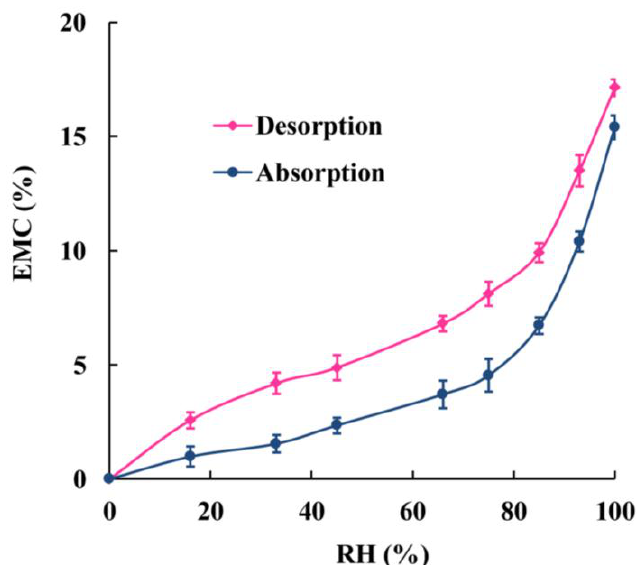
Figure 1. Typical sorption and desorption isotherms for type 1 WPC samples at 20 °C.